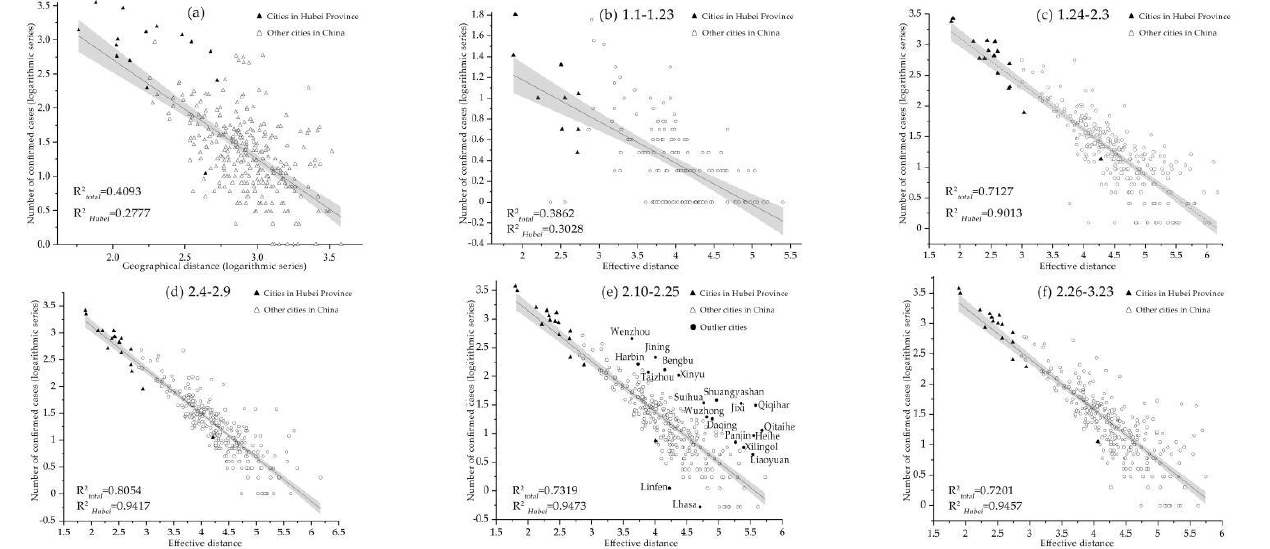
Figure 4. Factors correlated with confirmed COVID-19 cases. The relationship between the log-transformed geographical distance from Wuhan to nearly 300 cities and the log-transformed number of confirmed cases ( a ); ( b )–( f ), relationship over time between the log-transformed number of confirmed cases and the effective distance from Wuhan to destination cities.